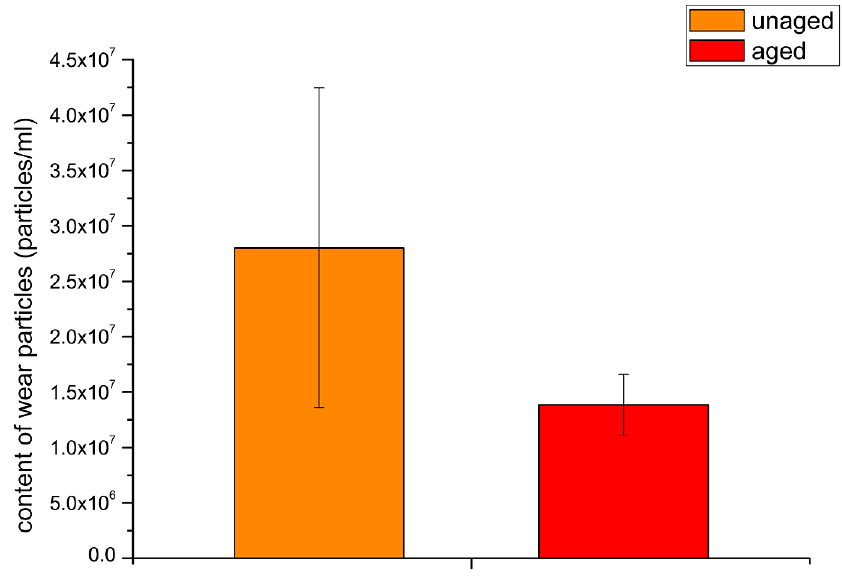
Figure 4. Amount of polyethylene wear particles.